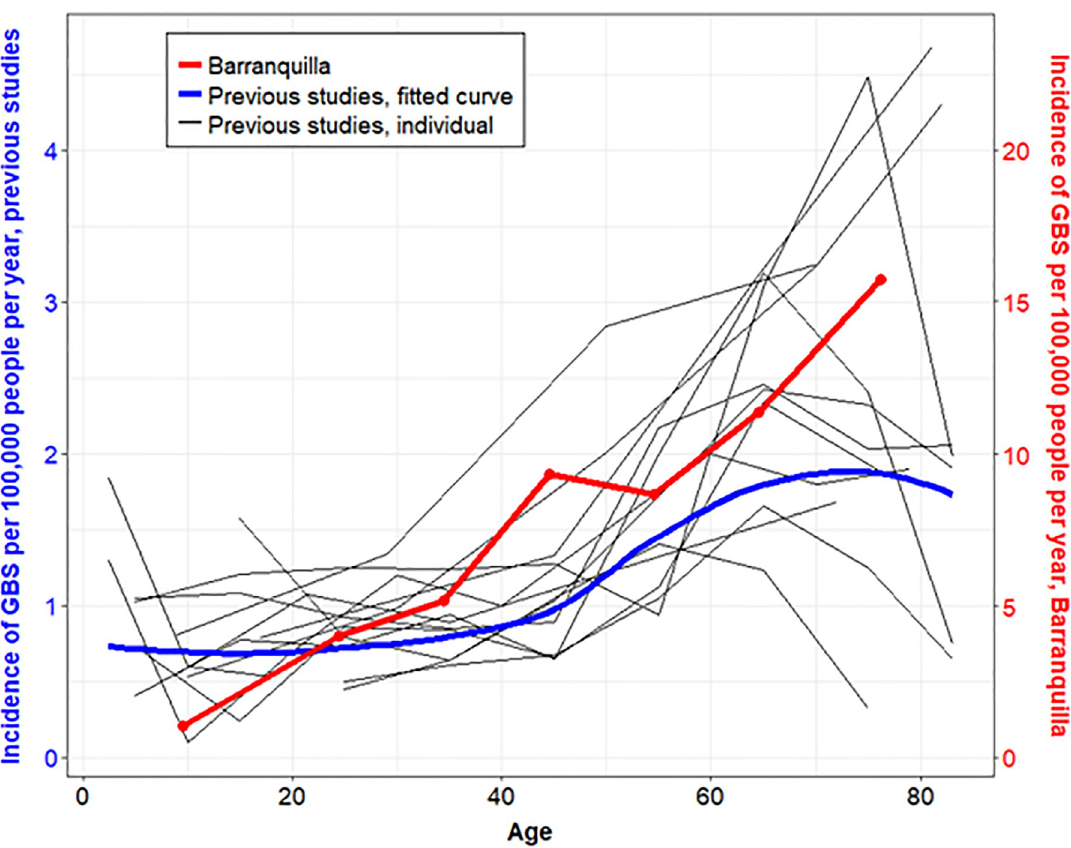
Fig 4. Incidence of GBS by midpoint of age groups, Barranquilla, Colombia, compared to previous studies. The red curve represents age-specific incidence for Barranquilla (right y-axis) and the black curves represent age-specific incidence for 13 previous studies (left y-axis). The blue curve (also left y-axis) represents a loess curve, weighted by person-years, fitted to incidence data from the previous studies. Data for previous studies from Sejvar et al. 2011.[2] While incidence generally increased with age in these previous studies, the observed association between age and incidence was even more pronounced in the Barranquilla investigation.